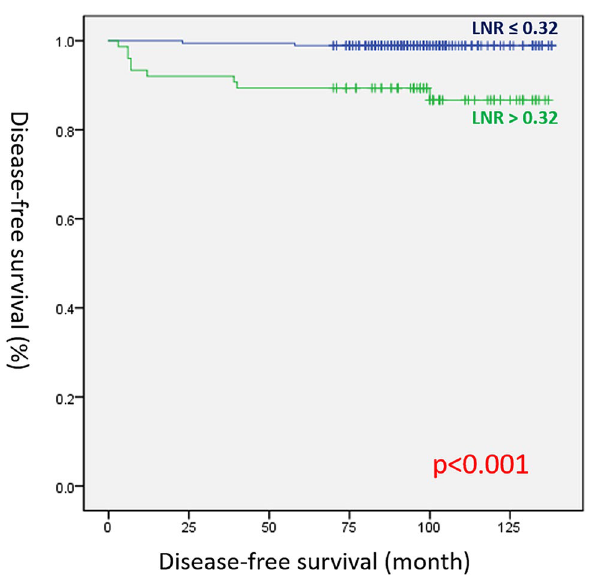
Figure 1. Disease-free survival curves according to lymph node ratio (LNR) (log-rank test, p <